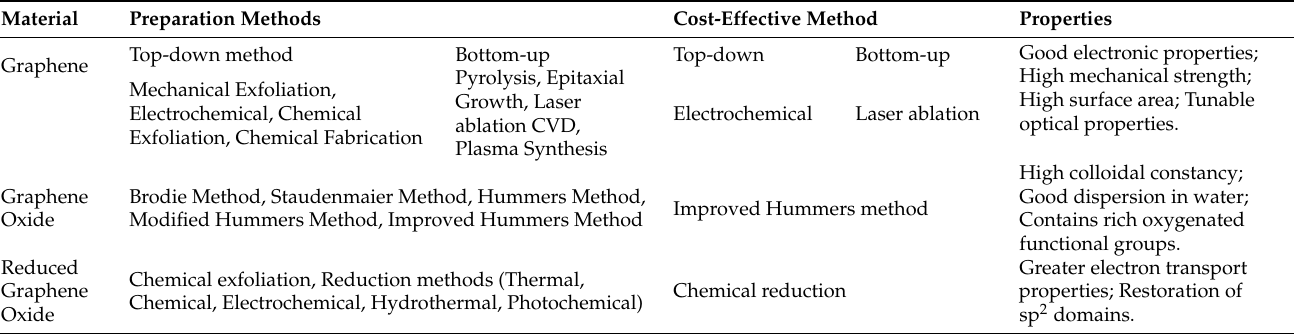
Figure 3. Flowchart of fabrication graphene and its derivatives through different chemical and physical routes. Table 2. Preparation methods, cost-effective route and properties of graphene and its